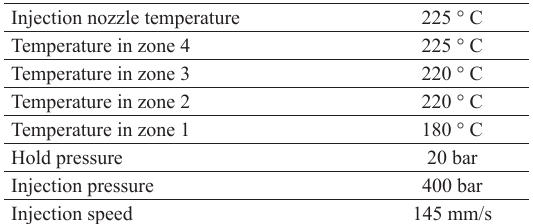
Table 3. Parameters used in the PP/25wt% bamboo fiber injection process.